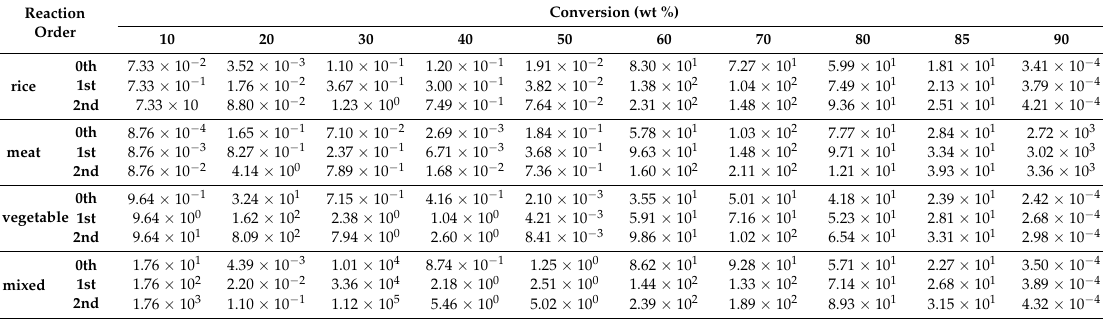
Table 4. Application of Equation (7) to calculate the pre-exponential factor with heating rate of 5, 10, 15 and 20 ◦ C/min for the pyrolysis of food